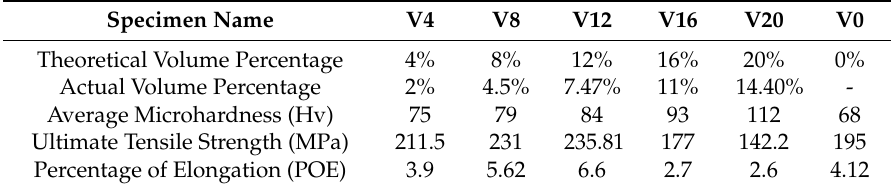
Table 4. Assessment values of AZ31B/SiC volume fractioned samples and the base material.